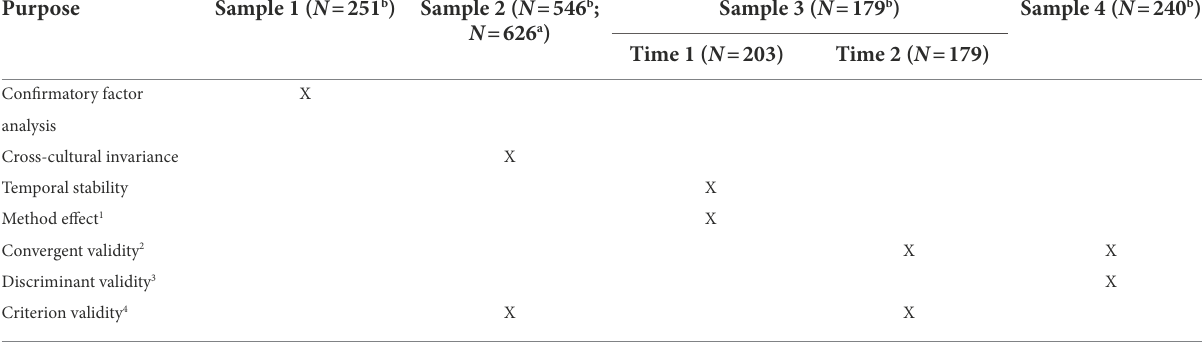
TABLE 1 Analysis procedures adopted and respective